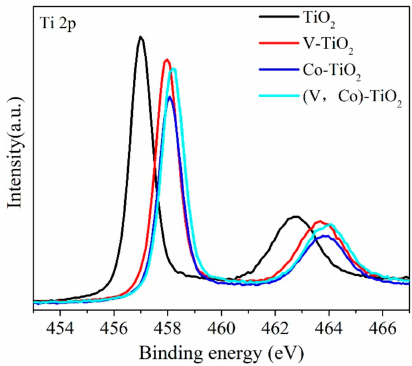
Figure 3. Ti 2p XPS spectra of TiO 2 , V–TiO 2 , Co–TiO 2 , and (V,Co)–TiO 2